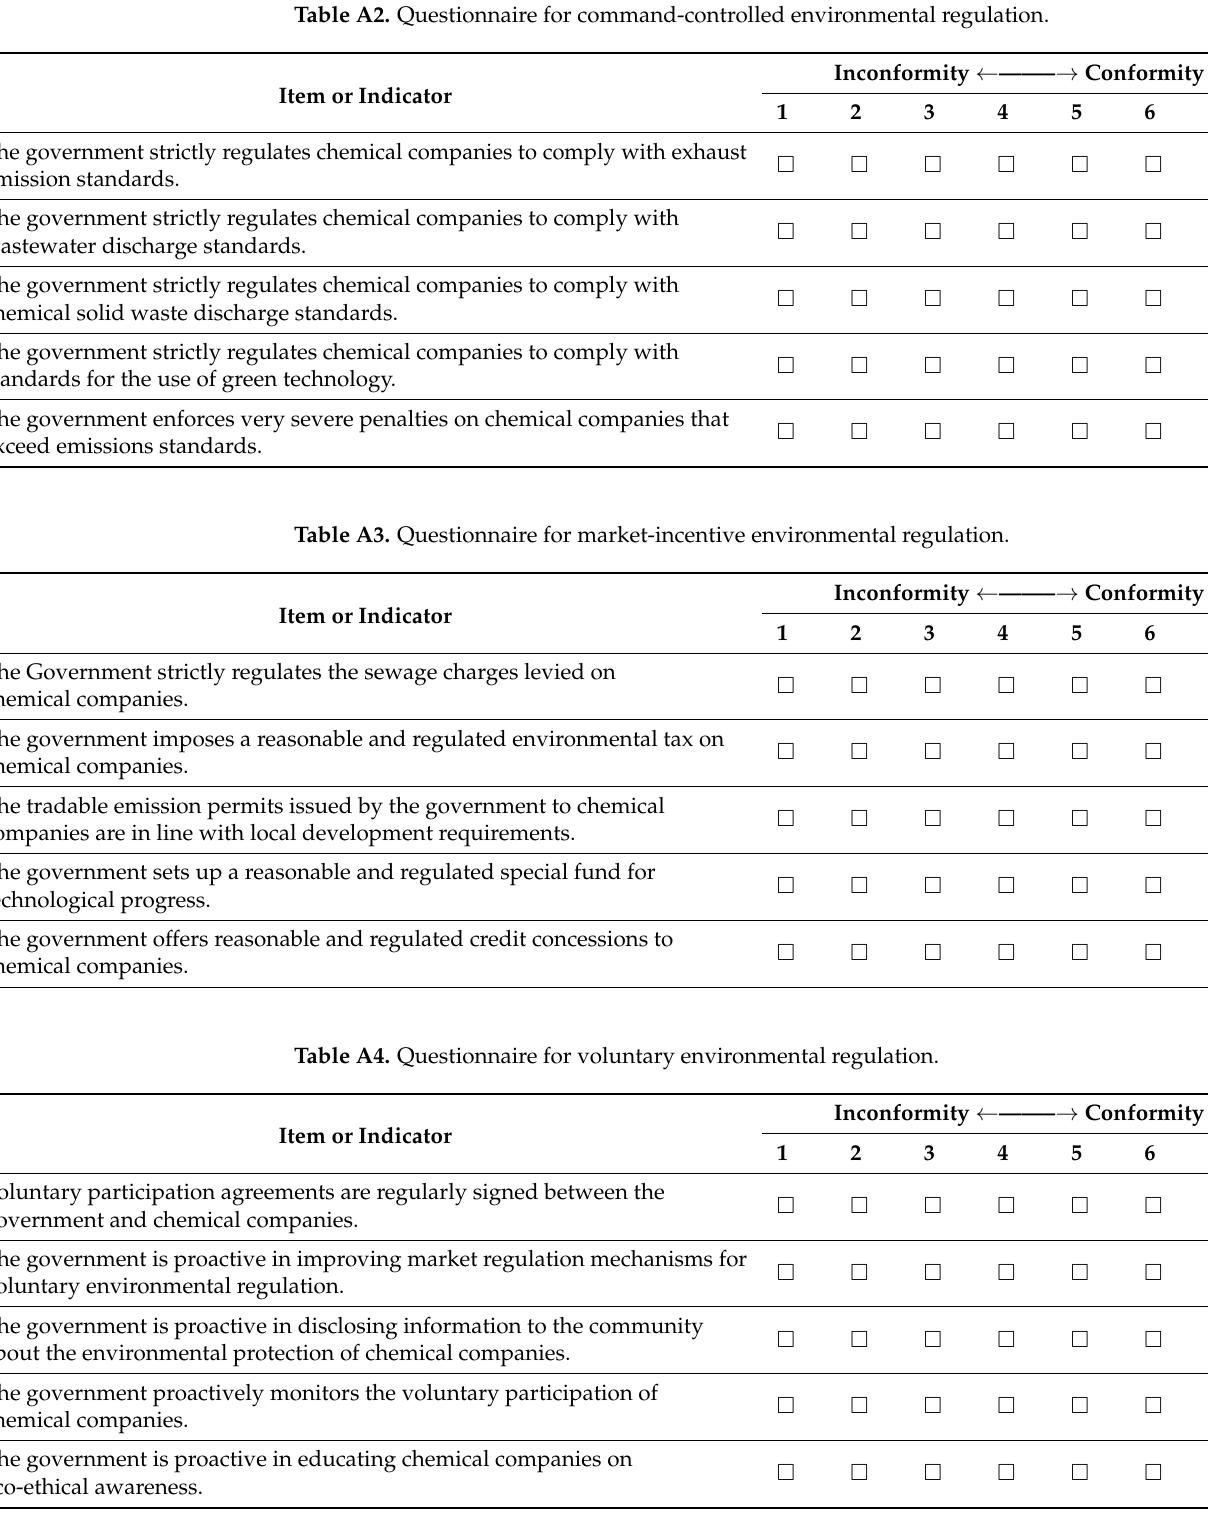
Table A2. Questionnaire for command-controlled environmental regulation.